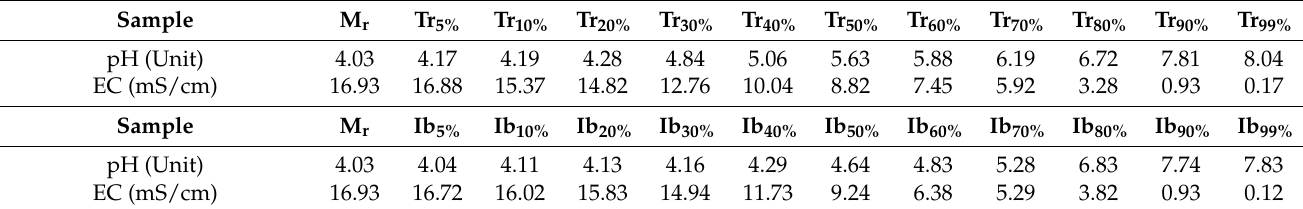
Table 4. Evolution of the pH and the electrical conductivity of the margin-bentonite mixtures